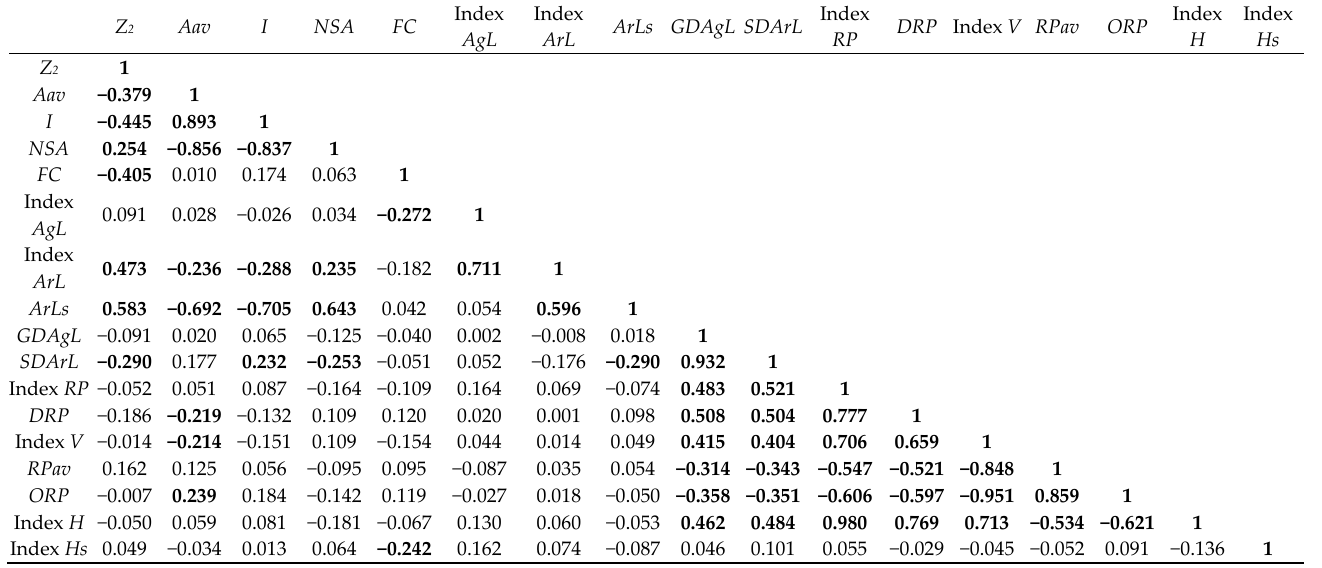
Figure 5. Eigenvalues and cumulative variance of principal components (high–high). Table 5. Correlation matrix of the principal component analysis [Pearson ( n )] for high–high cluster. Values in bold are different from 0 with a significance level α = 0.05.